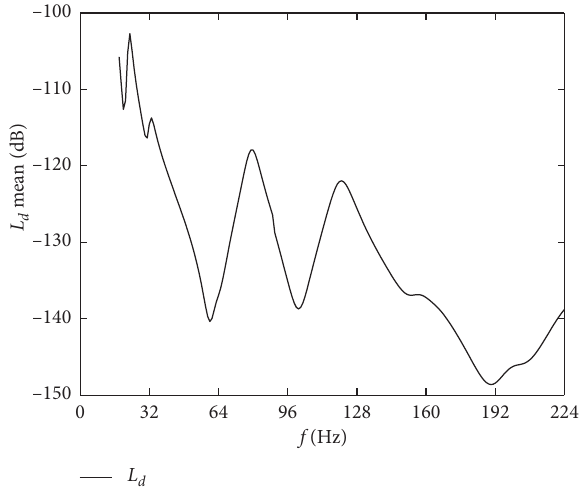
Figure 2: Mean model of the dynamic compliance.